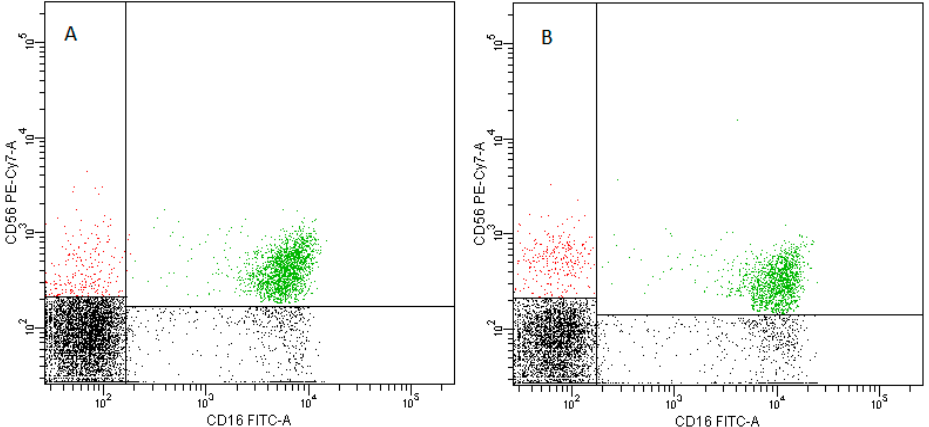
Figure 15. Exemplary plots of flow cytometry analysis showing the staining with antibodies specific for CD1c and CD19 in mononuclear leukocyte fraction: ( A ) peripheral blood ( B ) FNAB. Gating of B lymphocytes (CD19 + cells) is presented.